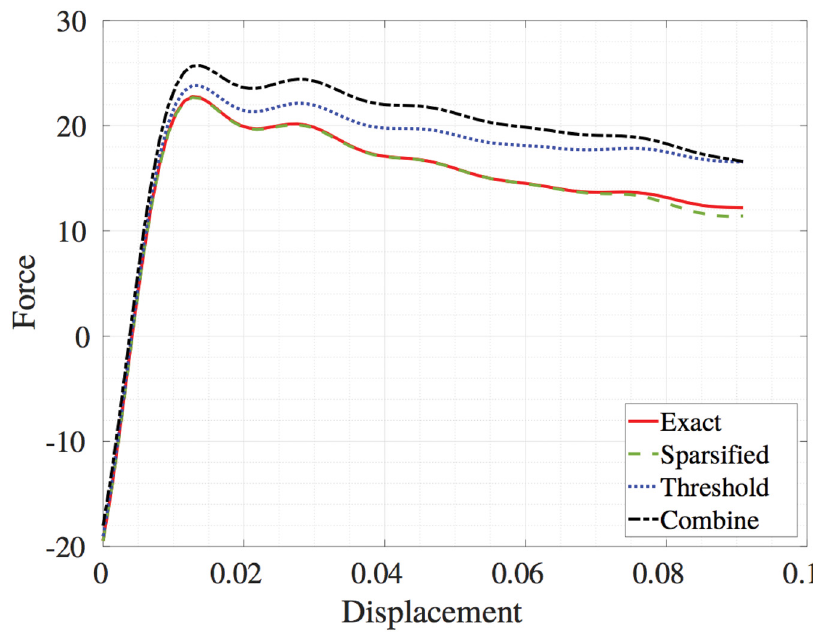
Fig 5. Force-displacement curve of the tensile simulation. Sparsification closely matches the force-displacement curve of the full graph (i.e., exact solution).